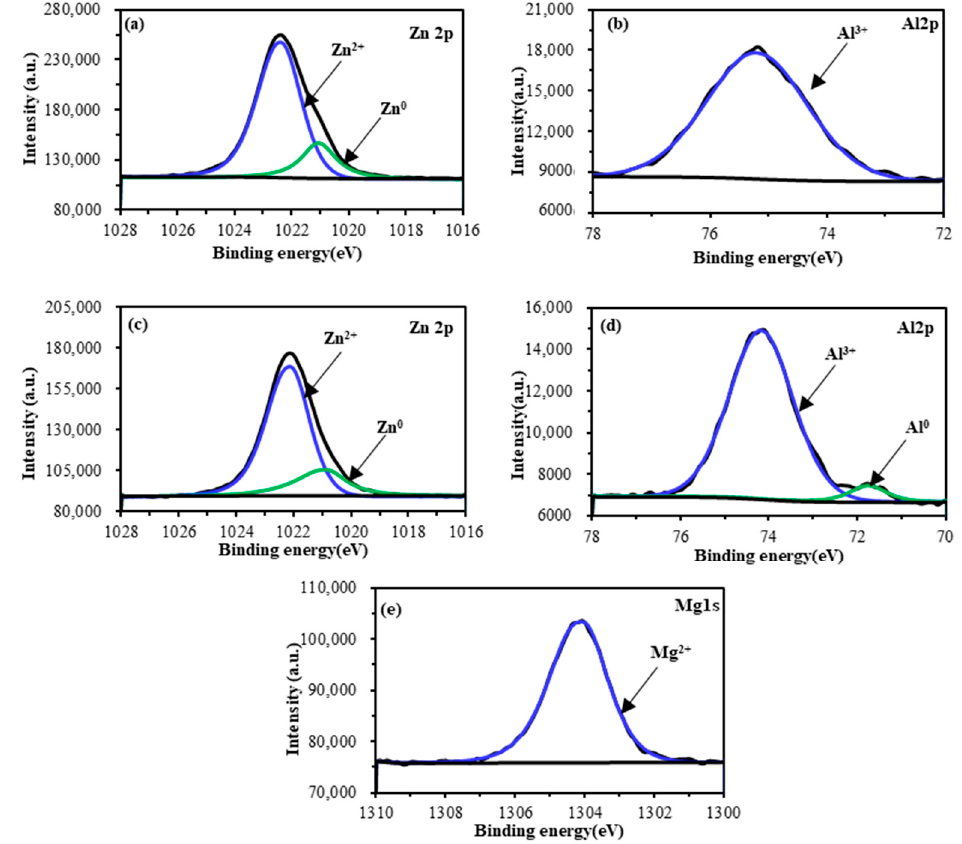
Figure 3. High resolution elemental spectra of ( a ) Zn 2p, ( b ) Al 2p of the Zn–Al coating, ( c ) Zn 2p, ( d ) Al 2p, and ( e ) Mg 1s of the Zn–Al–Mg coating.